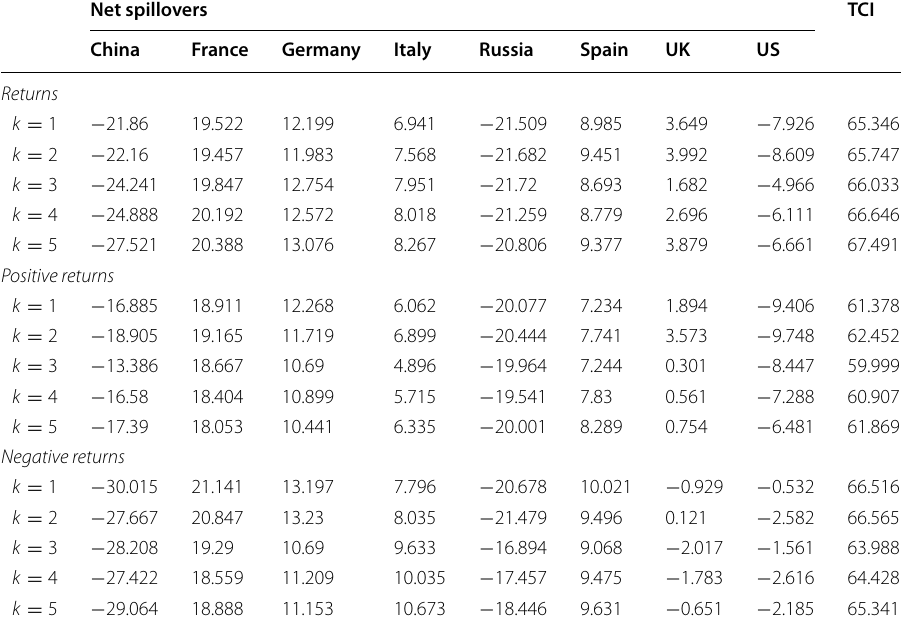
Table 5 Total and net dynamic connectedness averages based on different TVP-VAR lag